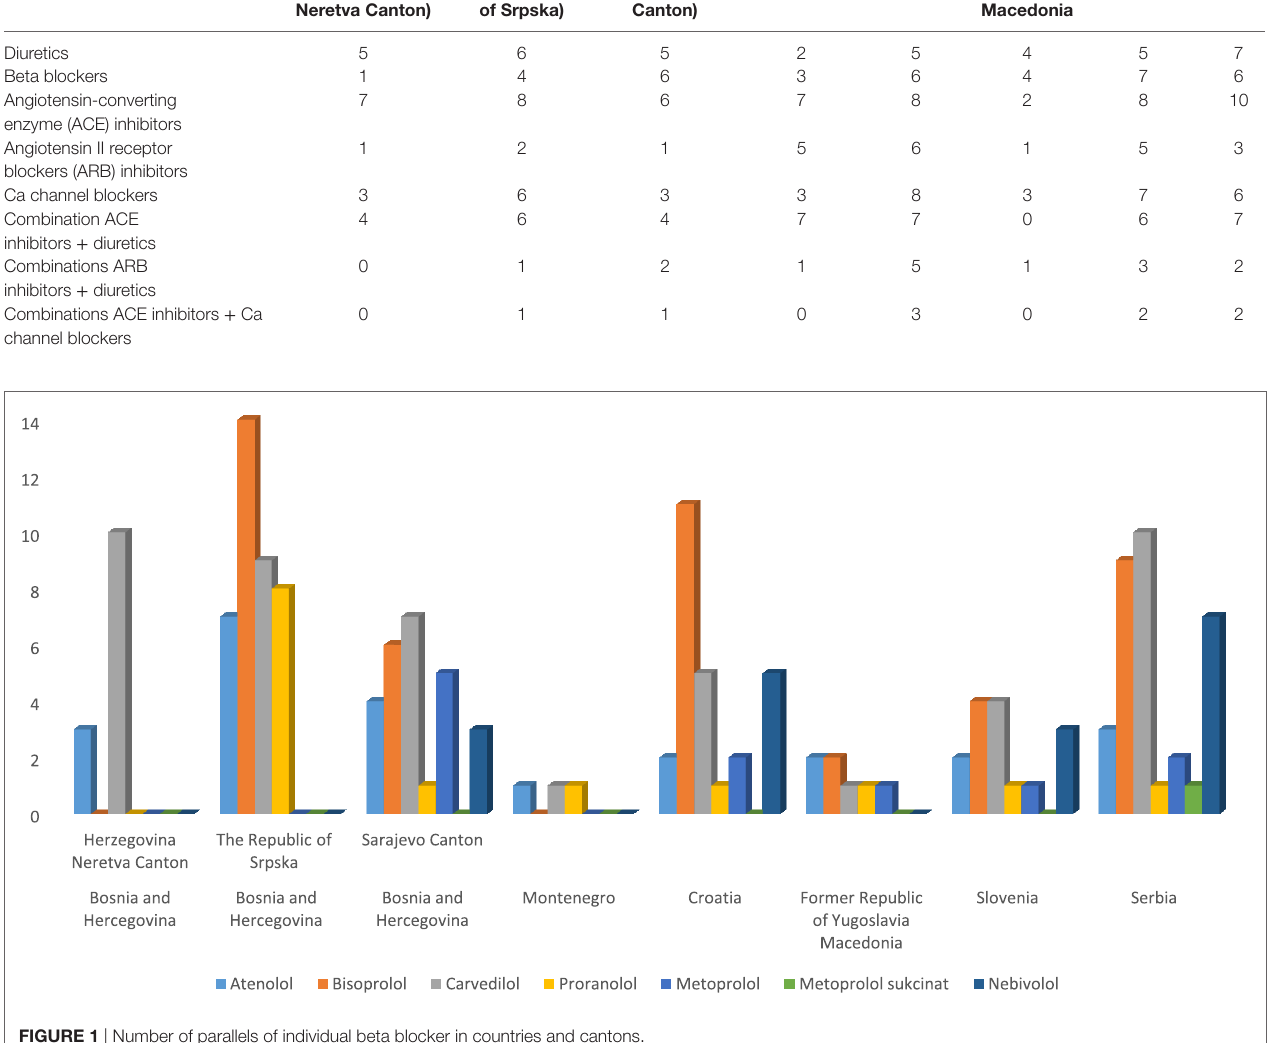
FigUre 1 | Number of parallels of individual beta blocker in countries and